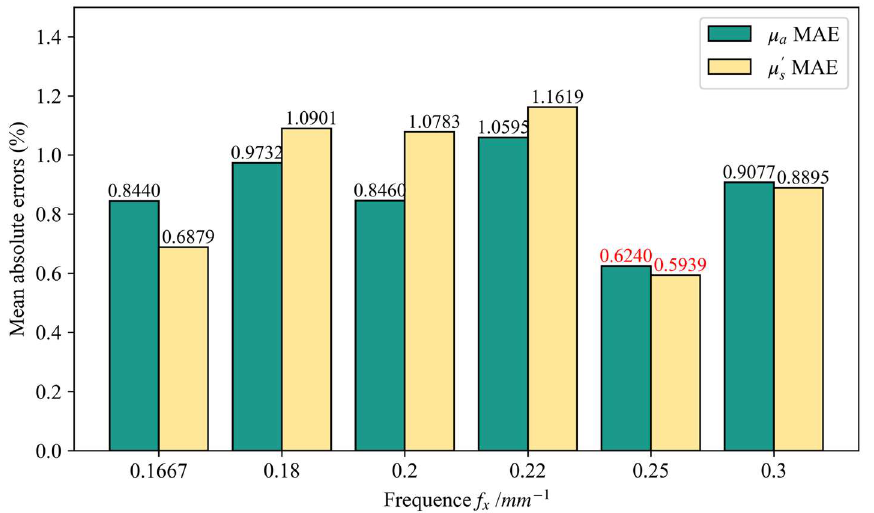
Figure 3. The Mean absolute errors of different models in predicting optical properties. The horizontal coordinate is the mapping model for different high frequencies. The numbers marked in red are the minimum mean absolute errors.